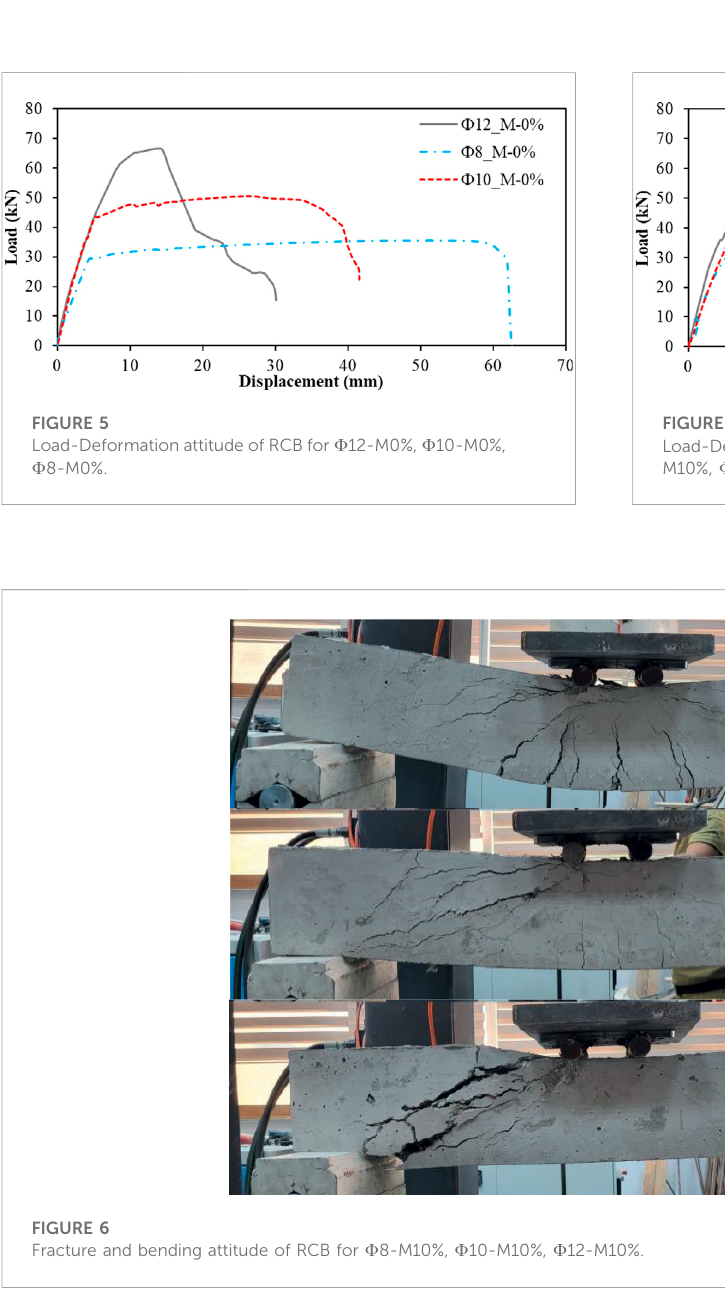
Figure 7, deformations recorded by LVTD are presented clearly and this graph is very remarkable to estimate the load-bending attitude of RCB with different amounts of tension reinforcement. According to Figure 7, bendings increased as a rectilinear line